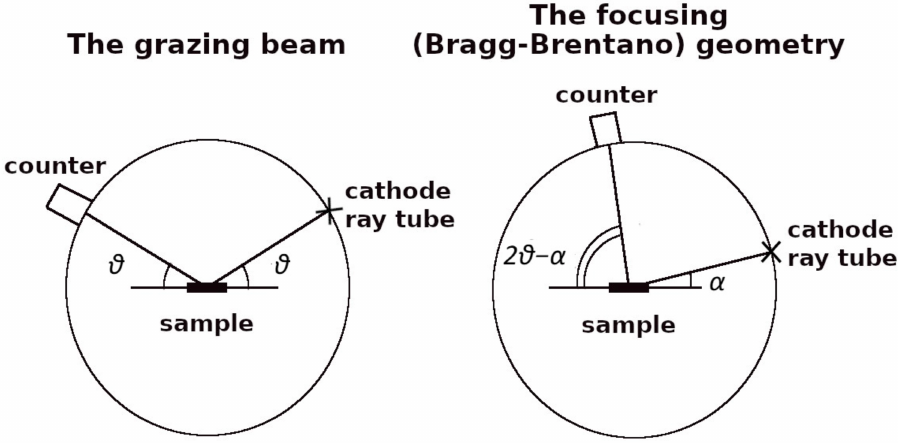
Figure 1. Symmetrical and asymmetrical diffraction geometries.